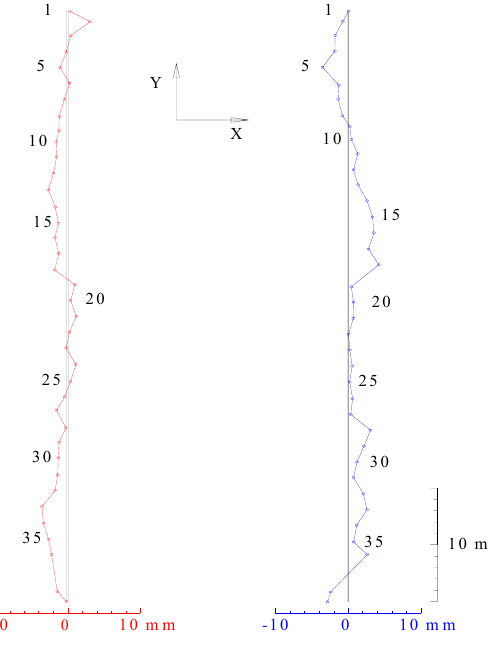
Figure 4. Graphical representation of deviations in horizontal sense (red—left rail, blue—right